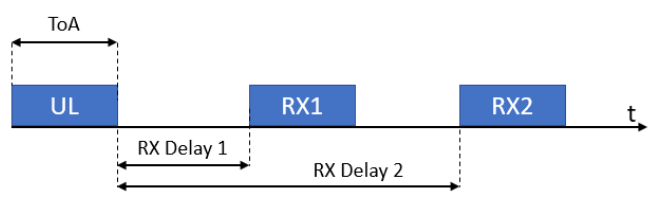
Figure 2. RX Windows in Class